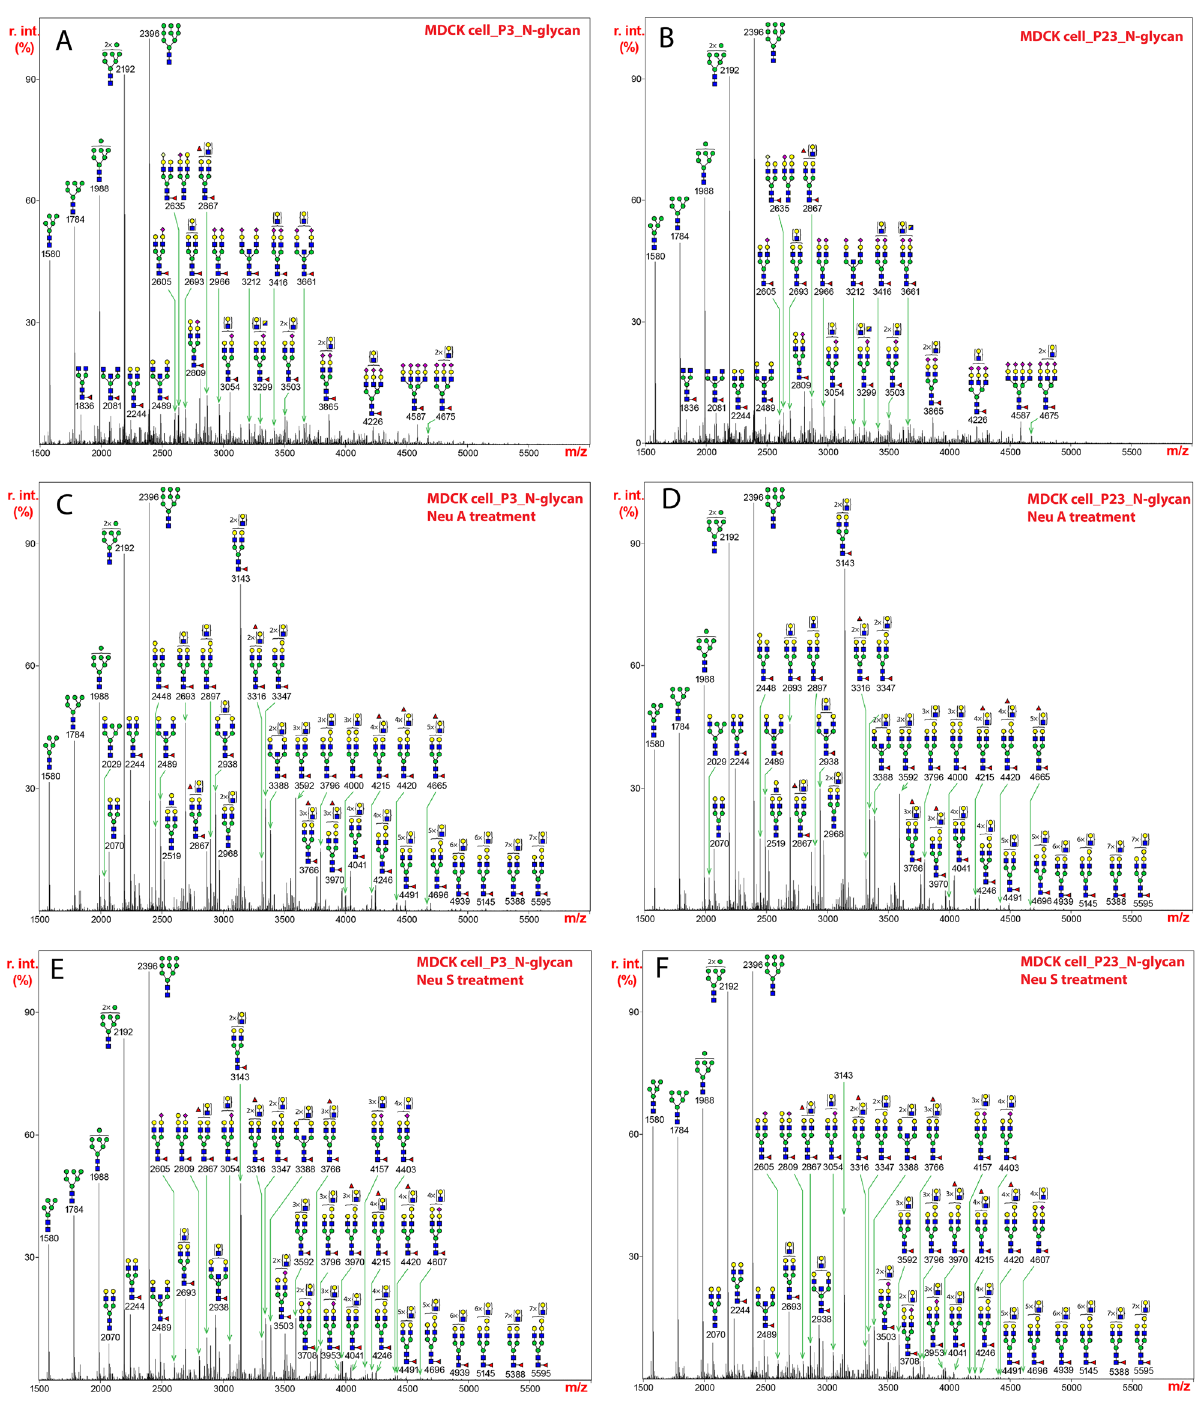
Figure 1. N-glycans released from extracts of MDCK cells by treatment with PNGase F, permethylated, and analyzed by MALDI-TOF MS. The medial molecular range between m/z 1500 and 5500 is shown. Putative structures based on compositions and corresponding to masses detected are represented next to the corresponding mass peaks. ( A ) N-glycans from MDCK cells at passage 3, and ( B ) N-glycans from MDCK cells at passage 23. ( C ) N-glycans in ( A ) from extracts of MDCK cells at passage 3 were treated with neuraminidase A and analyzed. ( D ) N-glycans in ( B ) from extracts of MDCK cells at passage 23 were treated with neuraminidase A and analyzed. ( E ) N-glycans in (A) from extracts of MDCK cells at passage 3 were treated with neuraminidase S and analyzed. ( F ) N-glycans in (B) from extracts of MDCK cells at passage 23 were treated with neuraminidase S and analyzed. The assignments of N-glycan mass and compositions, as well as relative percentage abundance of each glycan species in ( A ), ( C ), and ( E ) are presented in Supplementary Table